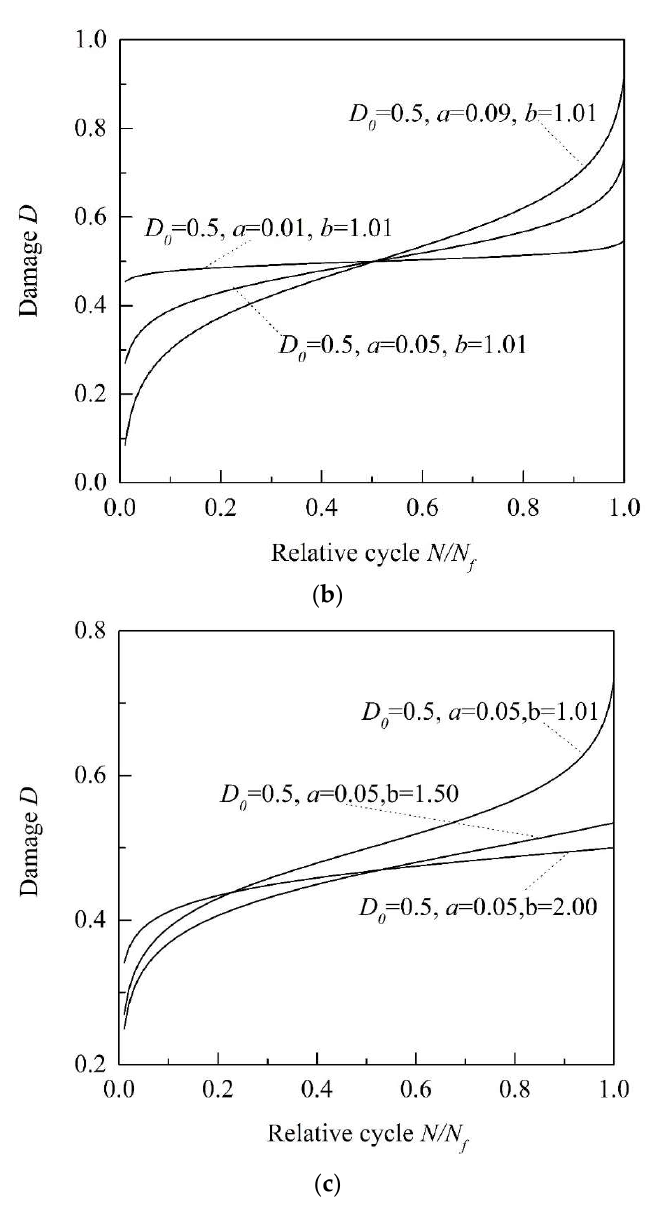
Figure 9. Effect of the inverted S-curve parameters: ( a ) parameter D 0 ; ( b ) parameter a ; and ( c ) parameter b .